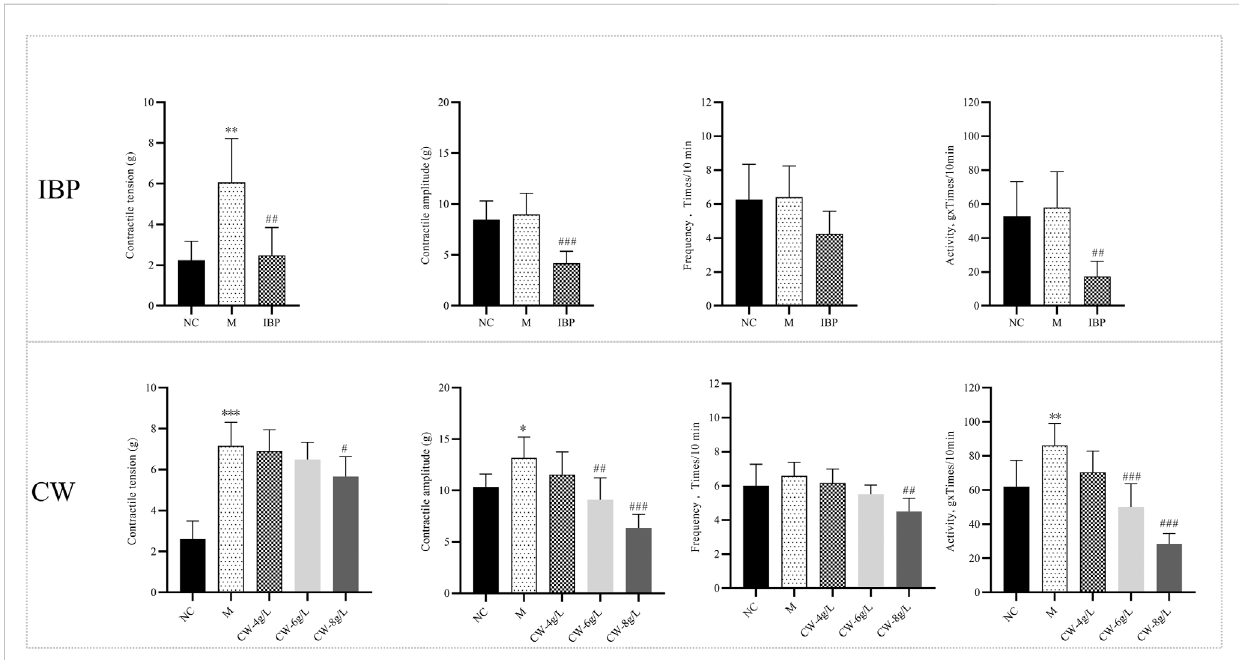
FIGURE 1 Effect ofextract ofCWon contractile oftheisolated uterus( ‾ x± s, n =6). Compared withblank curve, * p < 0.05, ** p < 0.01,*** p < 0.001;